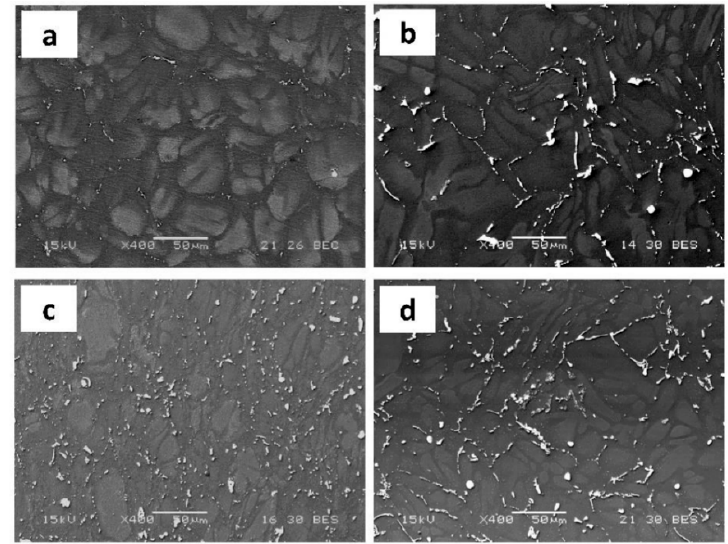
Figure 1. Typical microstructure of the tested alloys from SEM images: ( a ) Mg-5Zn; ( b ) Mg-5Zn-1Nd; ( c ) Mg-5Zn-2Nd and ( d ) Mg-5Zn-3Nd.